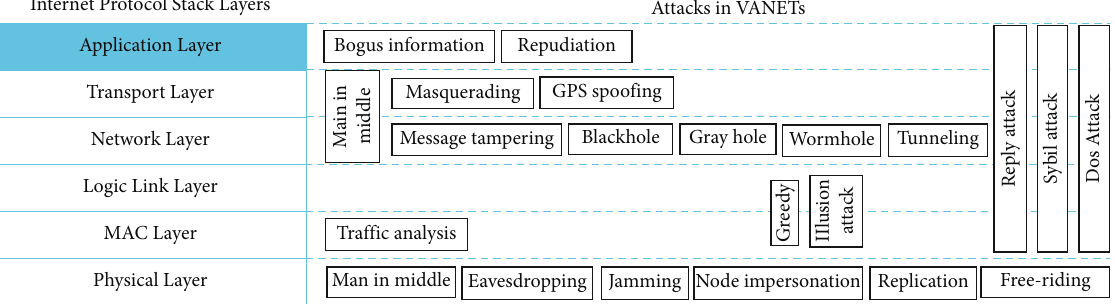
Figure 2: Attacks with corresponding Internet protocol stack